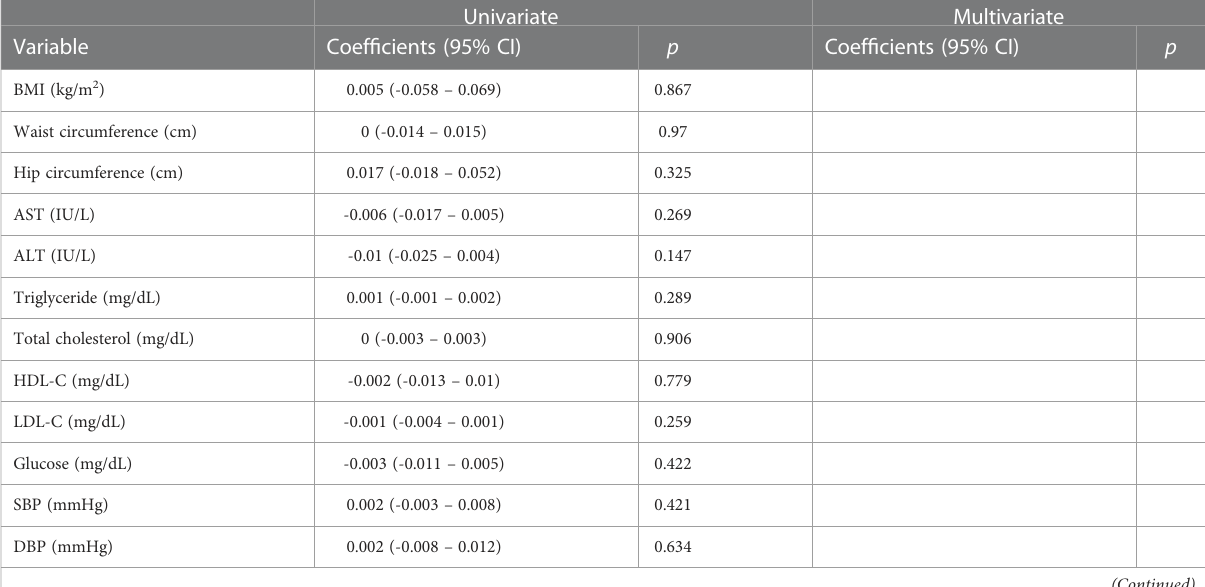
TABLE 5 Univariate- and multivariate analysis for changes in the levels of AmygA with changes in the levels of other variables on obese